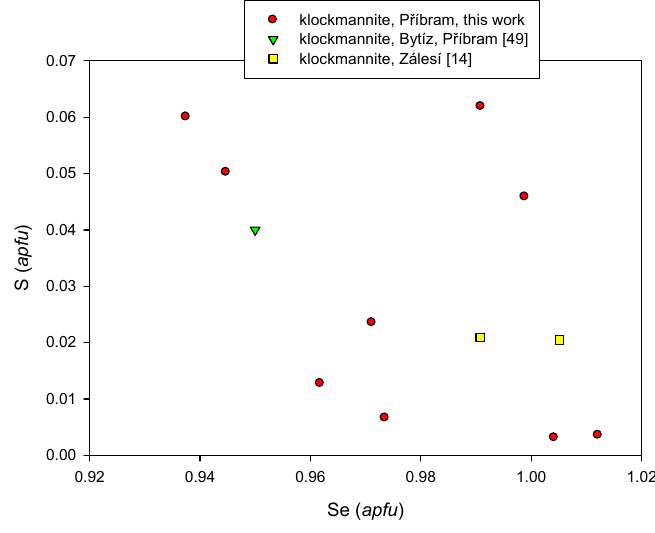
Figure 39. Se vs. S ( apfu ) graph for klockmannite.